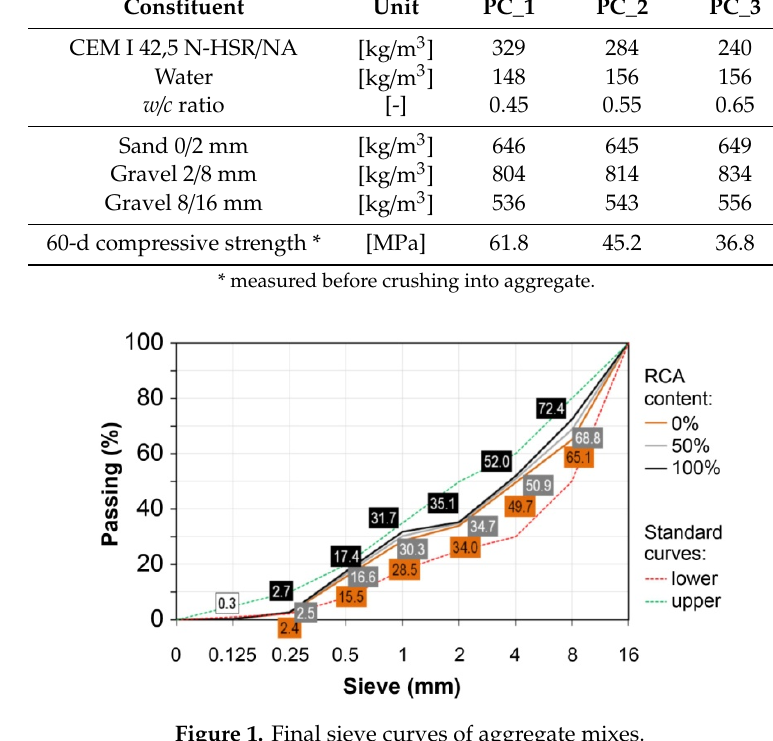
Figure 1. Final sieve curves of aggregate mixes.